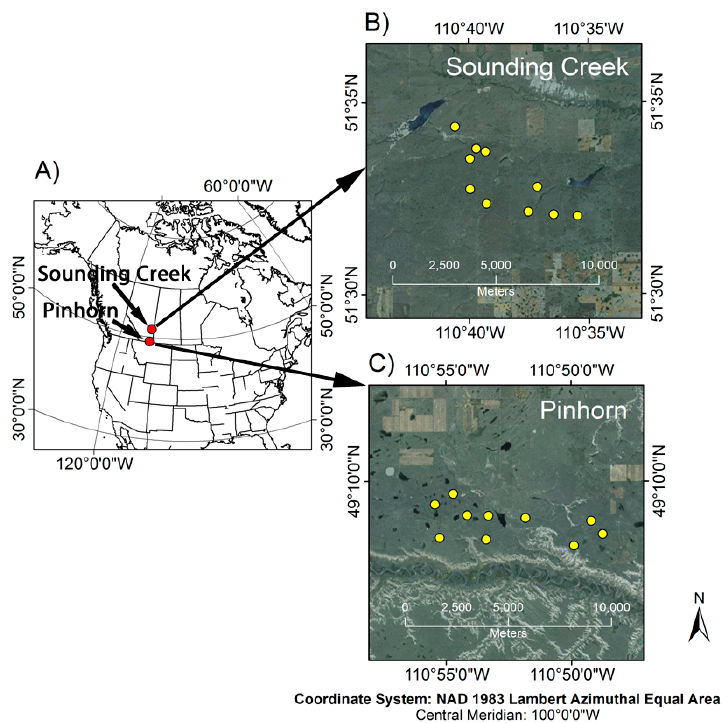
Figure 1. Location of study, showing the Sounding Creek and Pinhorn grazing reserves in Southern Alberta, Canada ( A ); Each grazing reserve contained 10 sampling locations (yellow circles, ( B , C )).